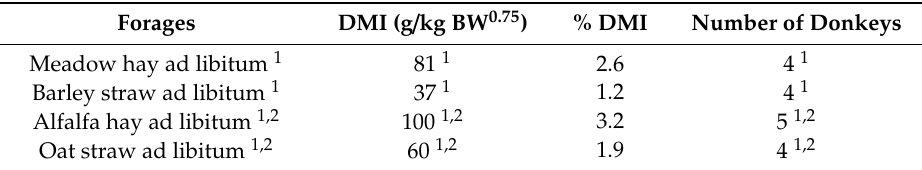
Table 5. Comparison of the dry matter intake (DMI) of di ff erent forages expressed in g / kg of BW 0.75 and percentage DMI / 100 kg